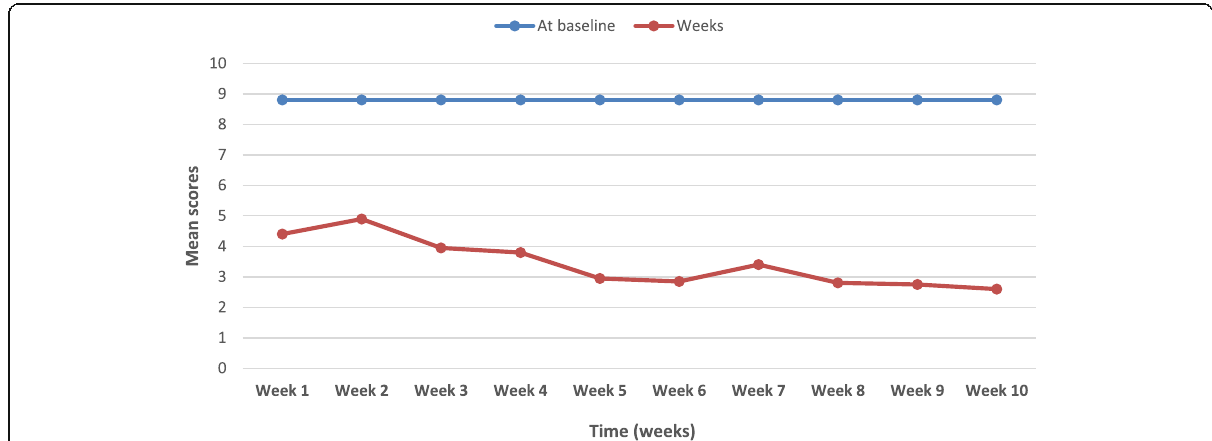
Fig. 2 Line graph showing the mean comparison of pain levels (post visual analogue scale scores) in females across 10 weeks compared with the baseline (after the intervention).This graph shows the baseline represented by the blue line. The blue line is constant throughout the study, the red line representing post-intervention VAS scores with spikes at the 2nd, 4th, and 7th weeks. The pain seems to plateau at the 8th, 9th, and